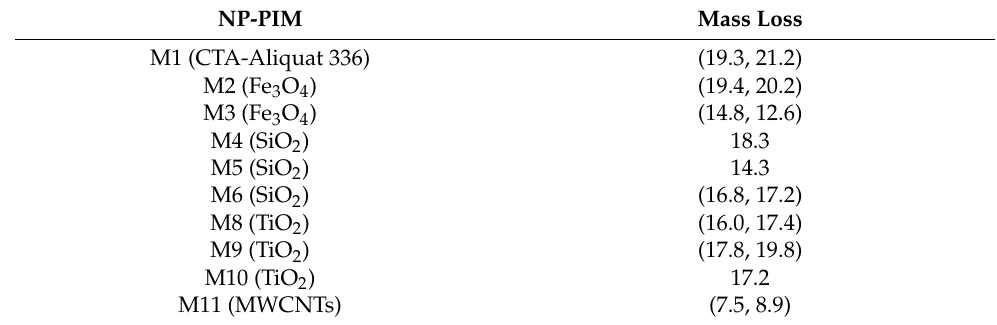
Table 3. Mass loss data for the NP-PIMs after 4 h in synthetic natural water (SNW). Results for two replicates are presented in